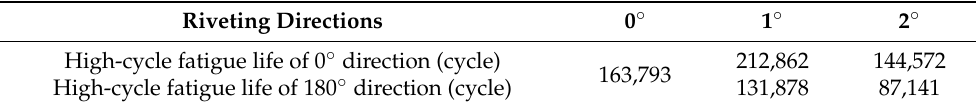
Table 5. High-cycle fatigue life of riveted joints at different riveting angles and directions.